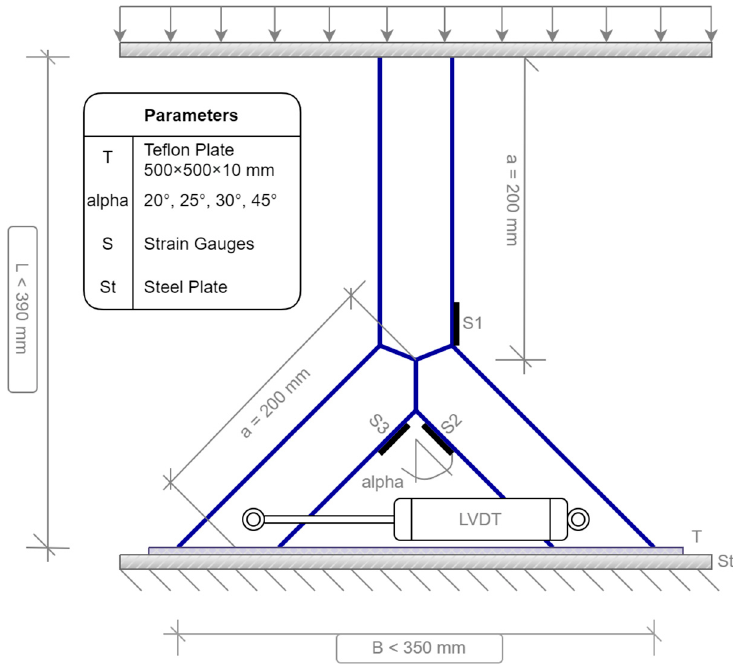
Figure 1. Laboratory test setup—model.